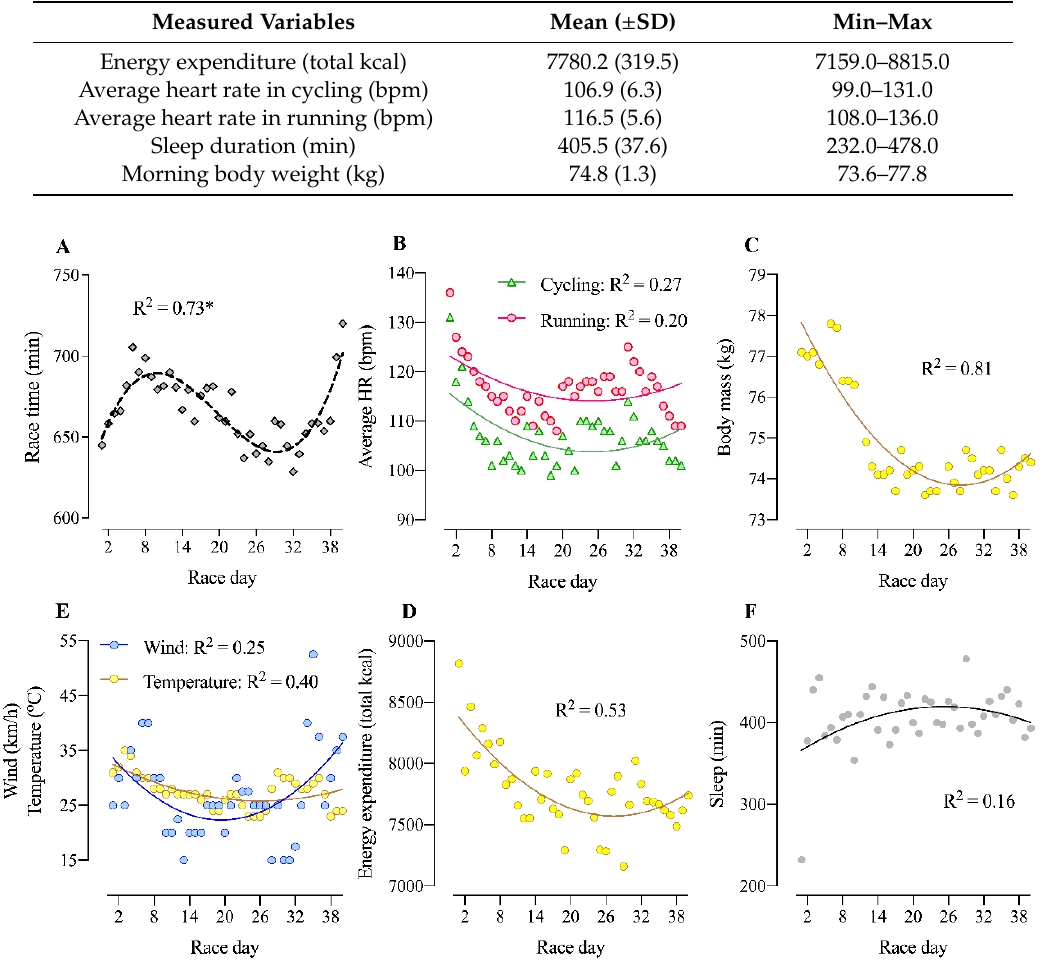
Table 2. Total energy expenditure, average heart rate, sleep time and body weight during 40 Ironman-distance triathlons for 40 consecutive days.